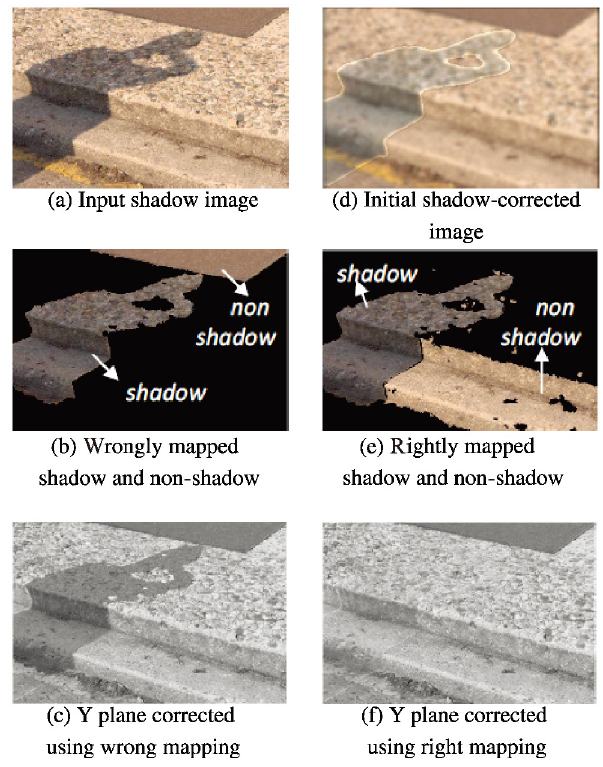
Fig. 6 Need for initial shadow